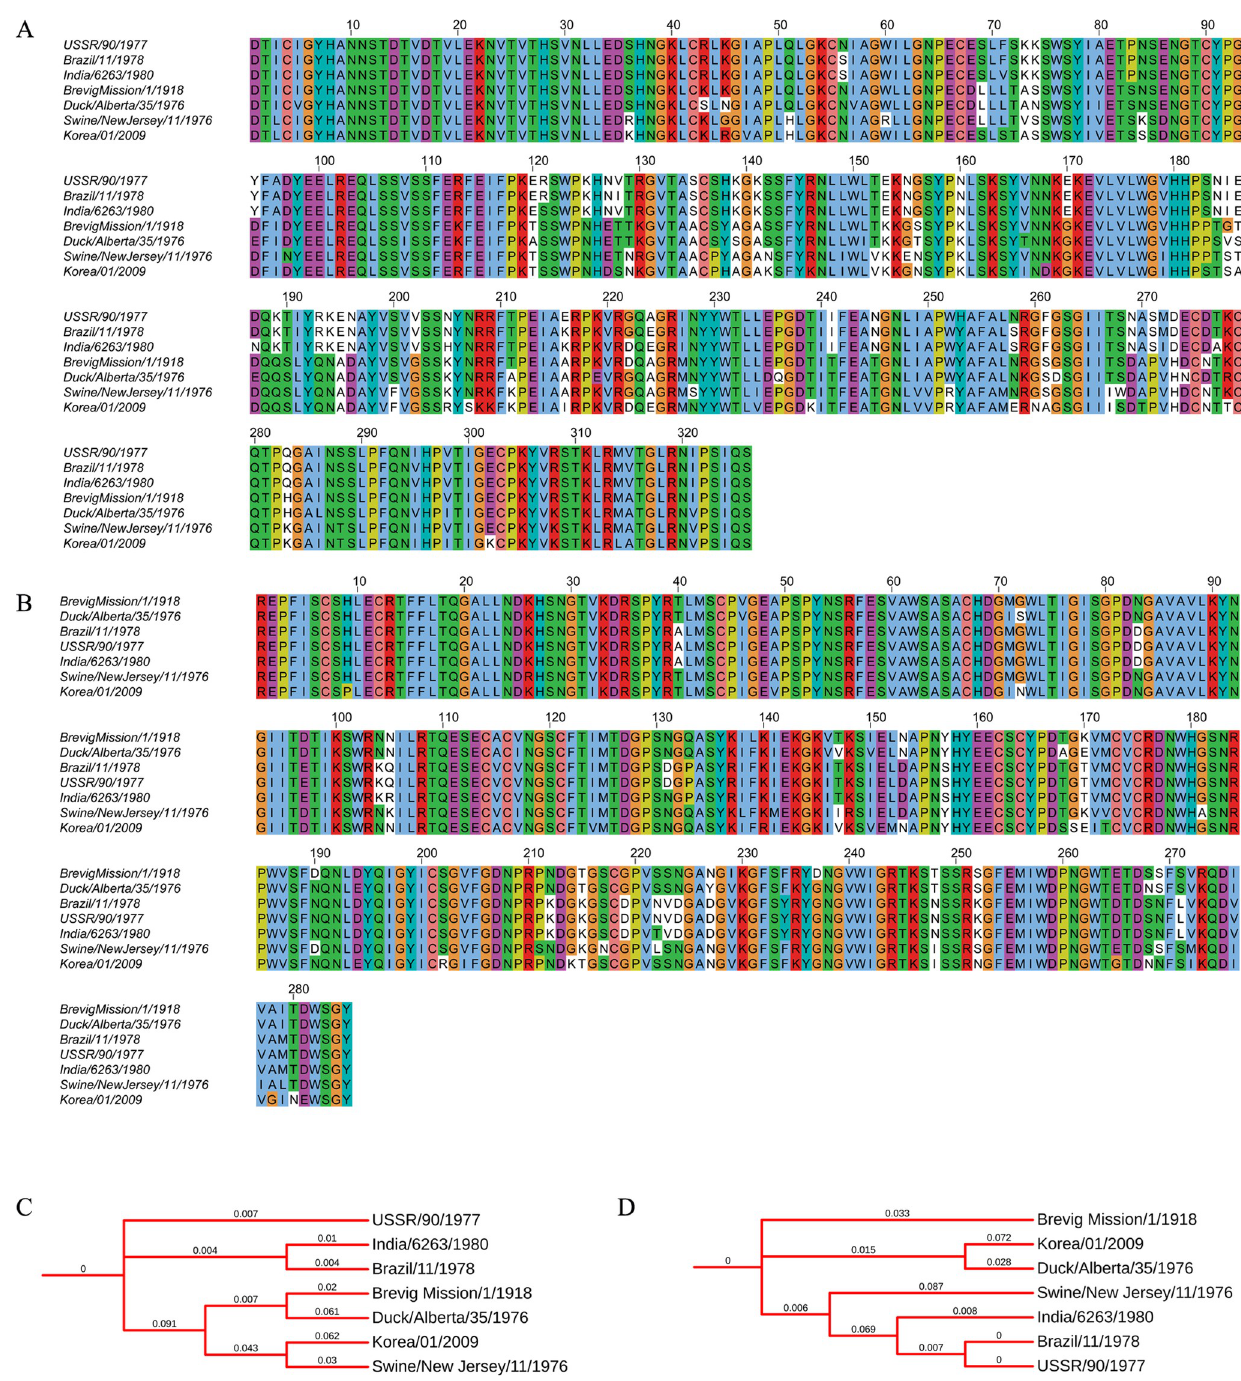
Fig 3. Phylogenetic profile of viral proteins from H1N1 Influenza A virus. Multiple Sequence Alignment of HA1 subdomain (A) of the hemagglutinin and active/binding site region of neuraminidase. (B) from different strains of the H1N1 Influenza A virus. (C) Phylogenetic tree of HA1 subdomain. (D) Phylogenetic tree of